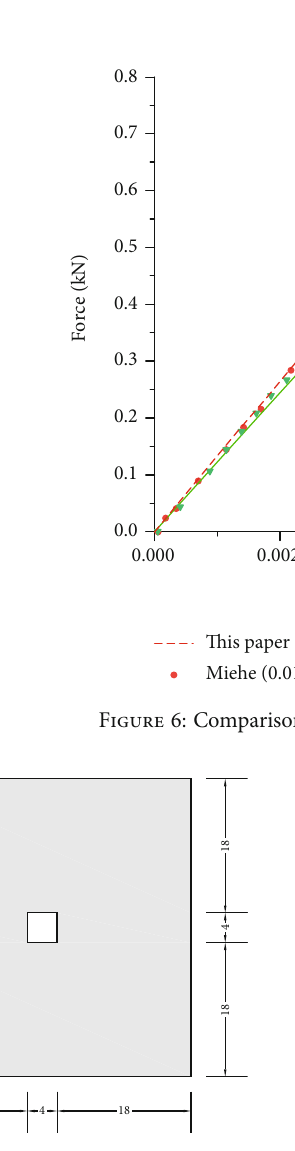
Figure 7: Prefabricated cavity plate model